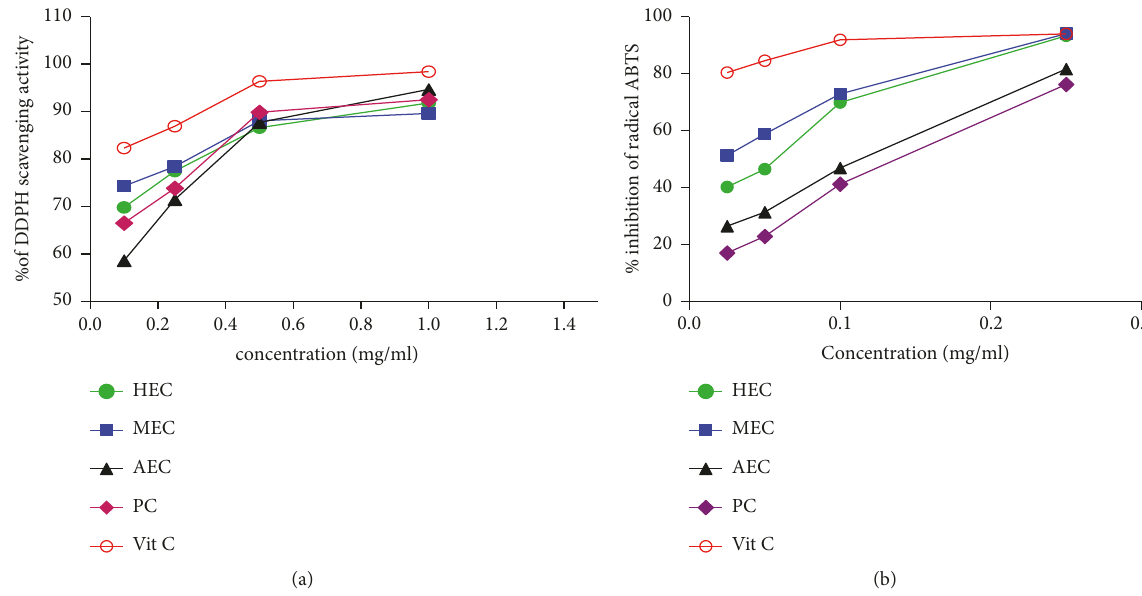
Figure 5: (a) DPPH radical scavenging activity of C. edulis . (b) Percentage inhibition of radical ABTS. HEC : hydroethanolic extract Carissa ;